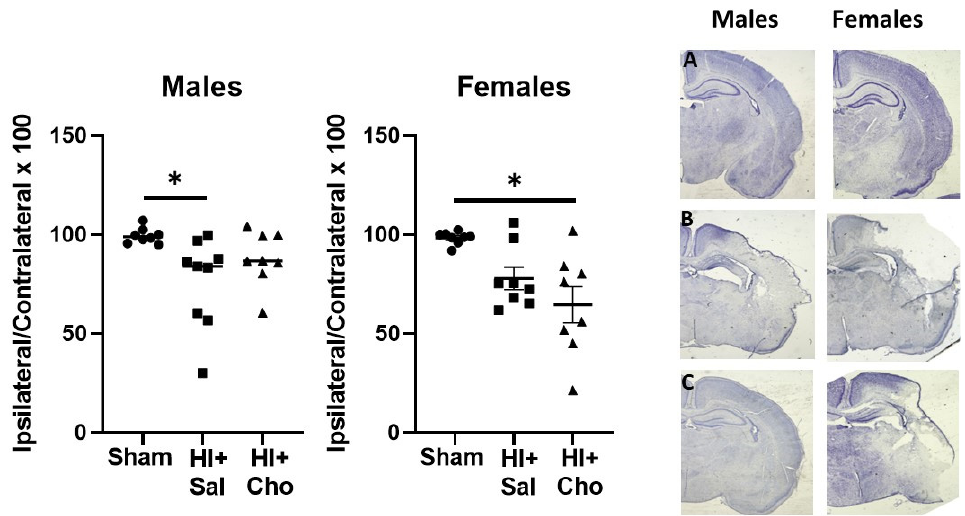
Figure 3. Choline supplementation improved histological outcomes at 72 h after HI in males but not females. Cerebral hemisphere volume was measure in sham operated control pups and pups subjected to HI on PND10. Tissue was collected 72 h after HI. The area of the contralateral and ipsilateral hemispheres was measured in 3 sections from a 1:12 series containing the dorsal hippocampus. Data are expressed as area of the ipsilateral/area of contralateral × 100. Male pups subjected to HI exhibited significant tissue loss compared to sham controls; only females treated with choline were significantly different from sham controls, * p < 0.05. Each group, n = 8. Representative images of the ipsilateral hemisphere of A: Sham male (left) and female (right) pups; B: HI+Sal male (left) and female (right) pups; C: HI+Cho male (left) and female (right) pups. HI = hypoxia ischemia; Sal = Saline; Cho = Choline.